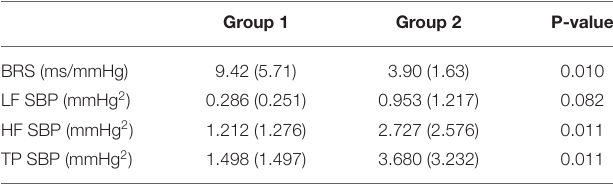
TABLE 2 | Comparison between two groups of newborns (Group 1 with higher gestational age, lower postnatal age; Group 2 with lower gestational age, longer postnatal